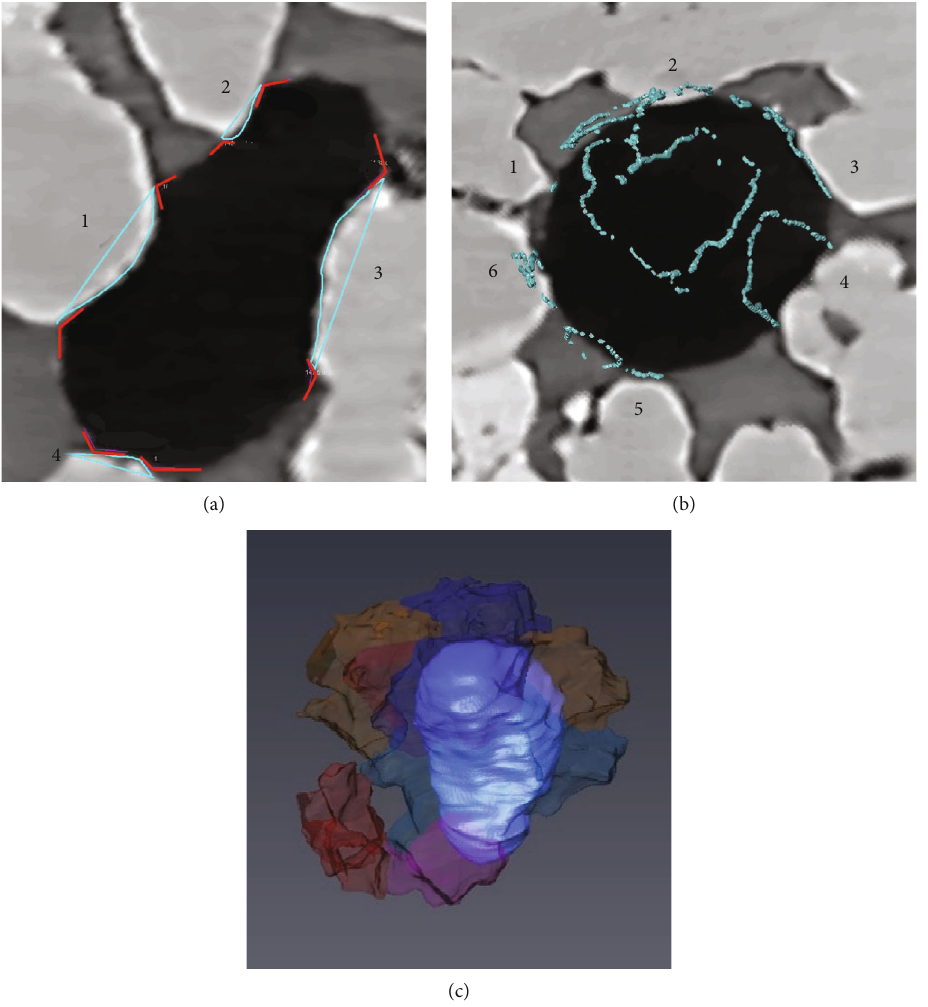
Figure 6: Grain contact surface: (a) scCO ganglion trapped in Bentheimer pore in contact with four grain surfaces (geometric contact angles 2 are shown in red on both sides of contact), (b) same scCO ganglion trapped in Bentheimer pore in contact with six grain surfaces (the teal 2 voxels represent the 3D contact line), and (c) 3D view of same pore showing ganglion in contact with six total surfaces where each color represents a di ff erent